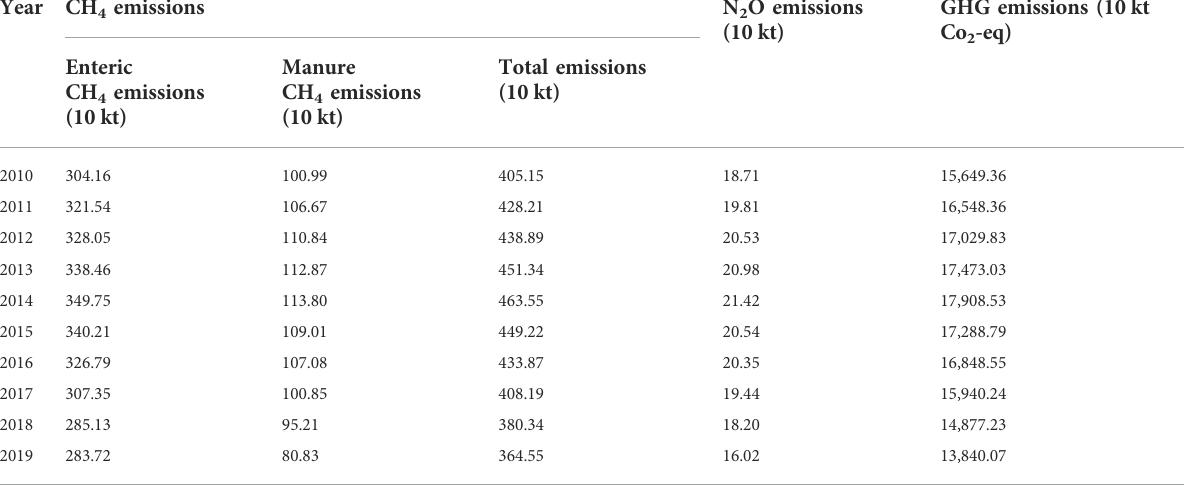
TABLE 3 GHG emissions in different emission categories from 2010 to 2019 in the CAGDMZ. Year CH 4